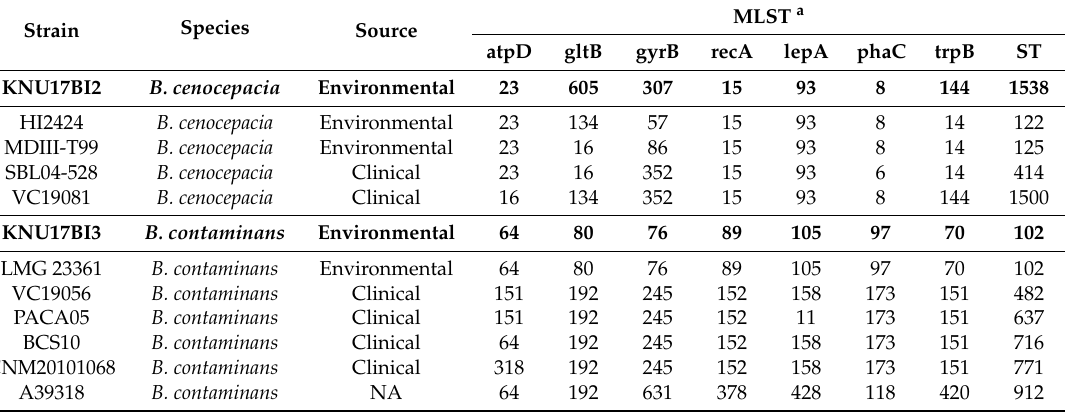
Table 1. Allelic profile of the seven loci of strain KNU17BI2 and strain KNU17BI3 as compared with closely related strains of B . cenocepacia and B . contaminans .